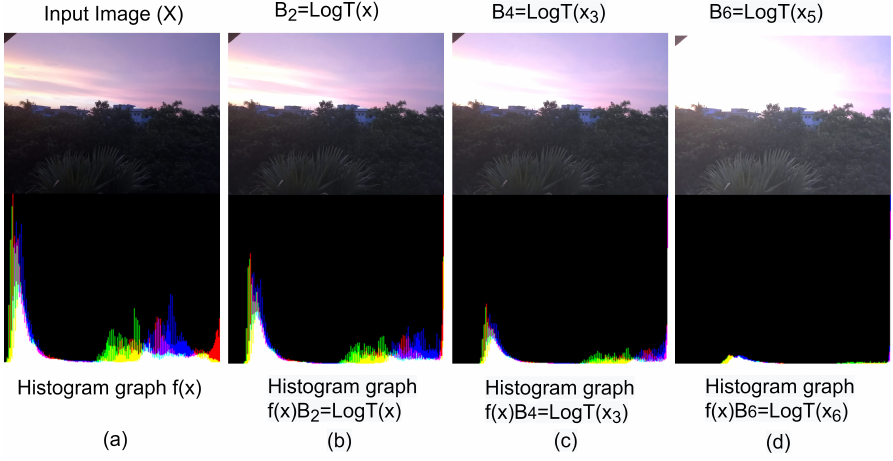
Figure 7. Analysis of Sequential Multiple Scale Logarithm Transformations of the Dark Input Image. ( a ) Histogram of the Given Image, ( b ) Histogram of the second stage Log Transformed Image, ( c ) Histogram of the fourth stage Log Transformed Image, ( d ) Histogram of the sixth stage Log Transformed